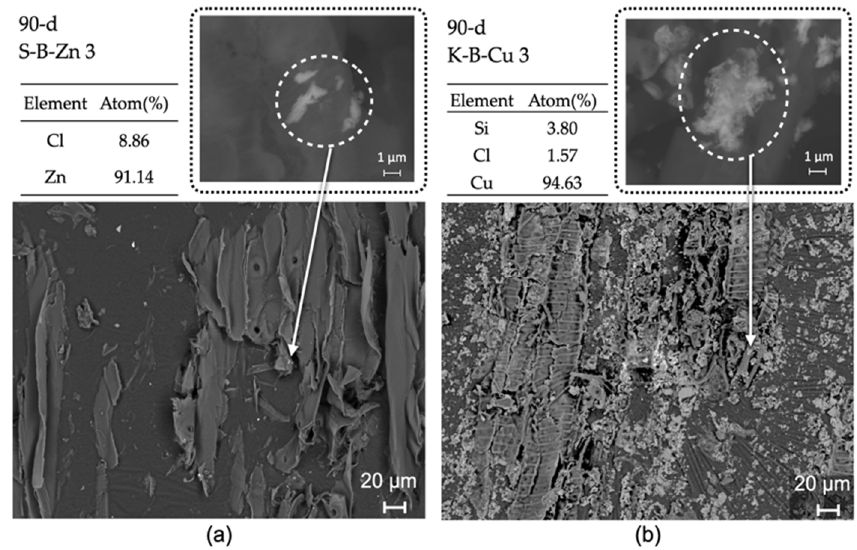
Figure 8. The qualitative analysis of scattered particles in the 90-day-exposed S-B-Zn 3 ( a ) and K-B-Cu 3 ( b ).